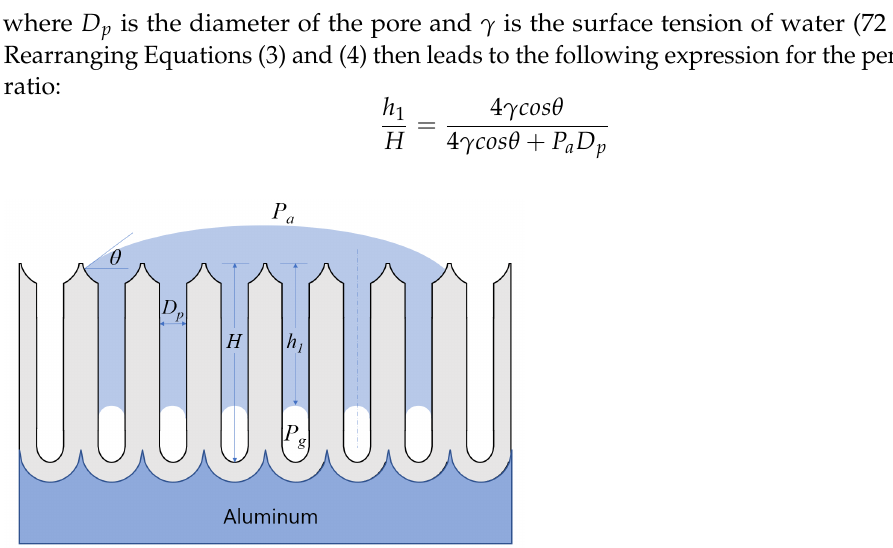
Figure 6. Liquid droplet on the nanopore structures produced by one-step and two-step anodizing.